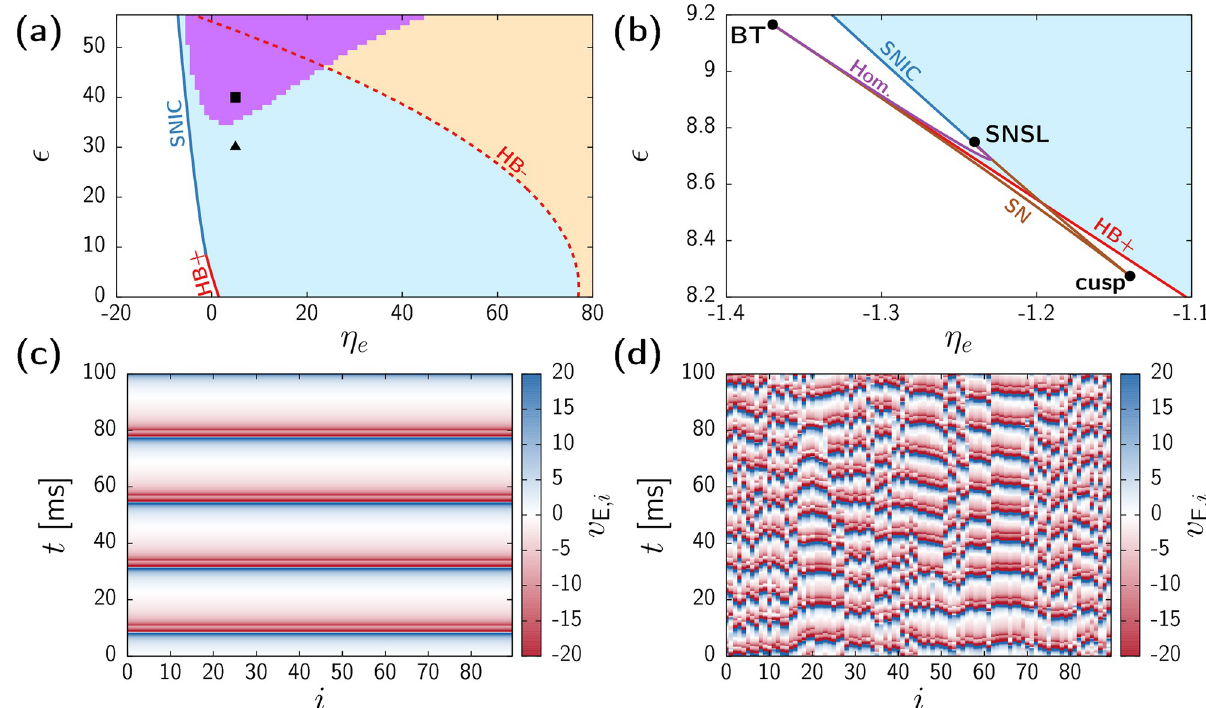
Fig 7. Dynamics of the large-scale brain model composed of NG-NMMs. (a,b) Complete bifurcation diagram of system (36). Panel (b) is a zoomed version of (a). Continuous lines correspond to the bifurcations of the homogeneous manifold given by Eq (38) obtained with AUTO-07p: saddle-node on an invariant cycle (SNIC, dark blue), supercritical Hopf (HB+, continuous red), subcritical Hopf (HB-, dashed red), saddle-node (SN, brown), and homoclinic (Hom., purple). Light blue shaded region indicates stability of the homogeneous gamma activity. Orange shaded region indicates bistability between homogeneous gamma activity and a fixed point. Pink shaded region indicates the region of transverse instability of the synchronized oscillations. Black triangle and square in panel (a) indicate the parameter values corresponding to panels (c) and (d) respectively. (c,d) Time evolution of each node as obtained from a numerical simulation of Eq (36) for � = 30 (c) and � = 40 (d). In both cases η e = 5.